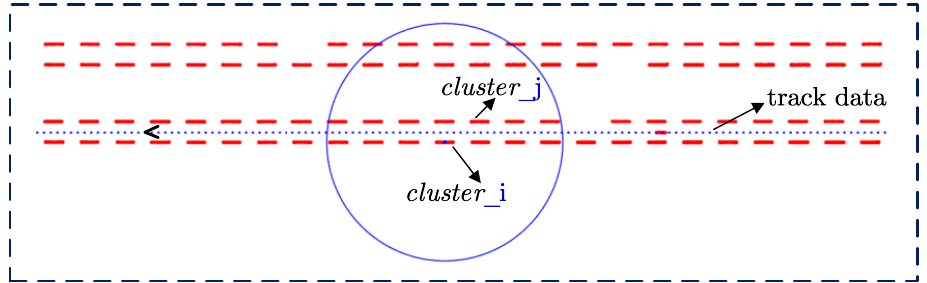
Figure 8. Diagrammatic sketch of the determination of growth point.